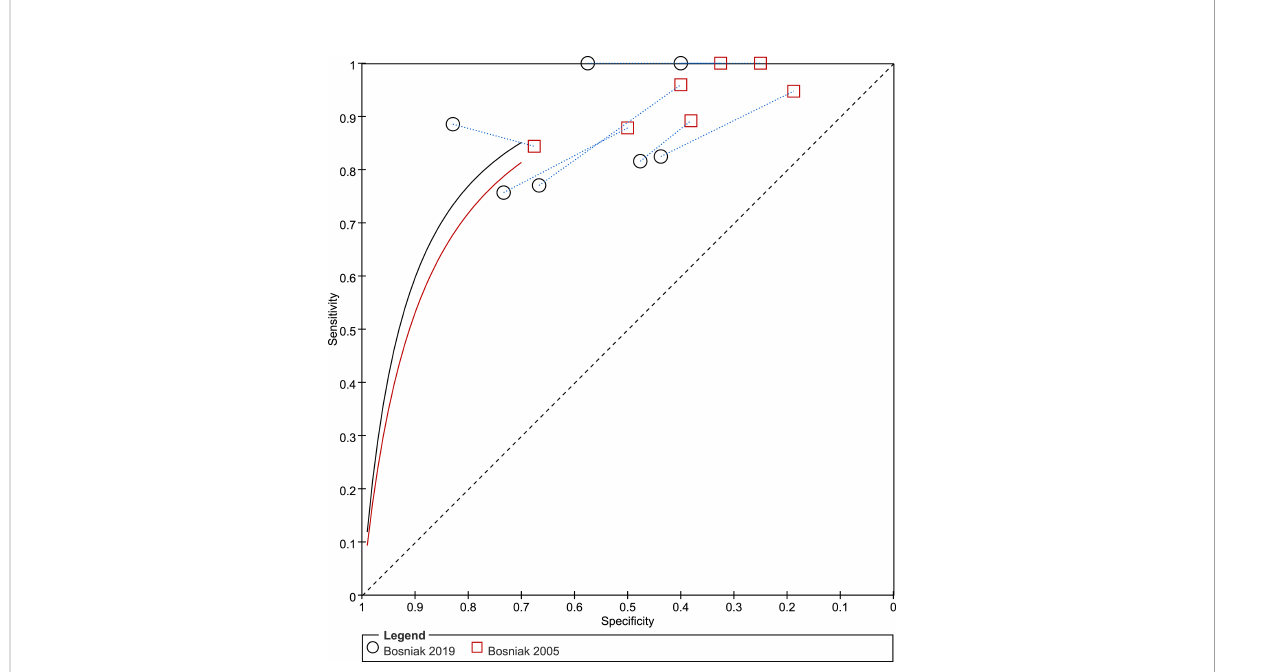
FIGURE 6 Summary receiver operating characteristic (ROC) performance curves for the Bosniak classi fi cation, version 2019 and version